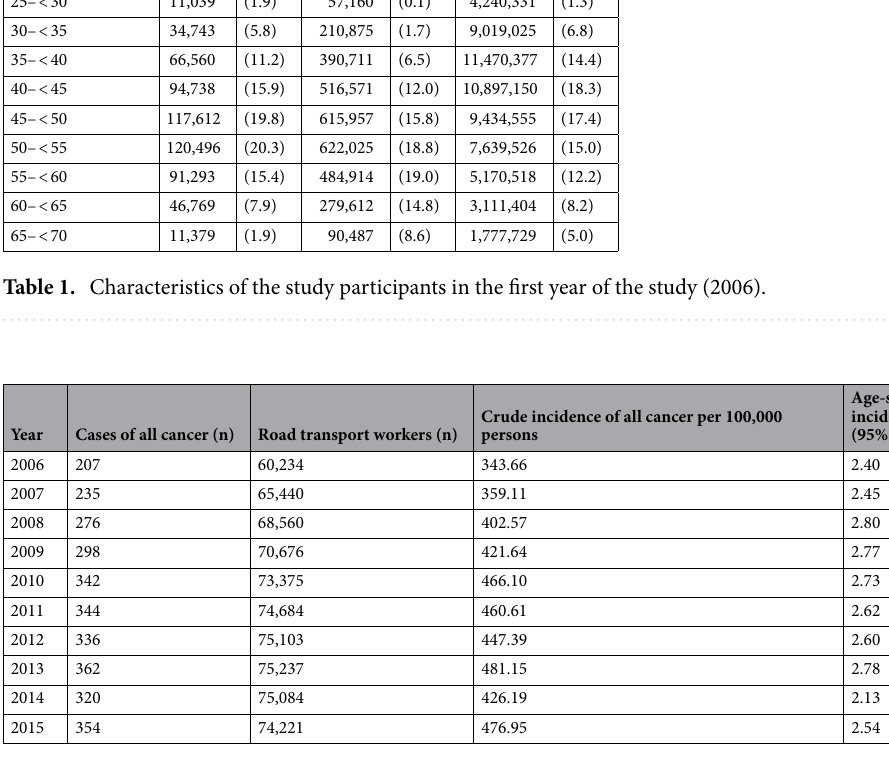
Table 2. Age-standardised incidence ratios of all cancers—a comparison between the general working population and all road transportation workers in Korea by year. Age-standardised incidence ratio was calculated with direct standardisation methods for 5-year age